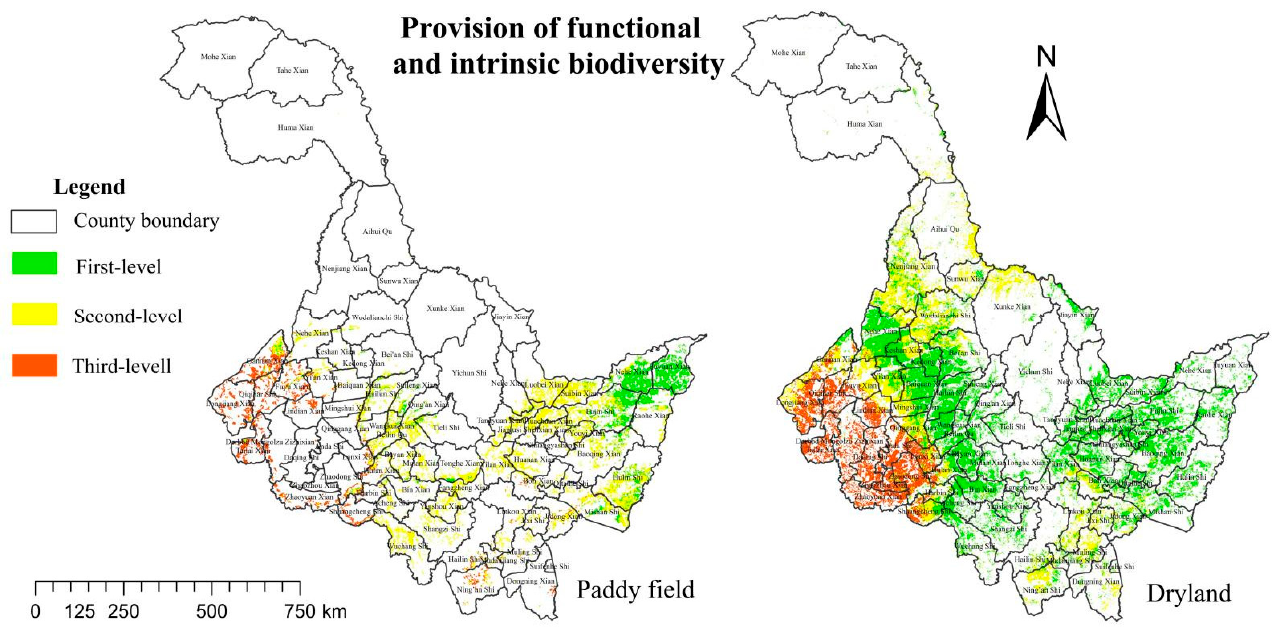
Figure 7. The grade of provision of functional and intrinsic biodiversity function in paddy fields and drylands.